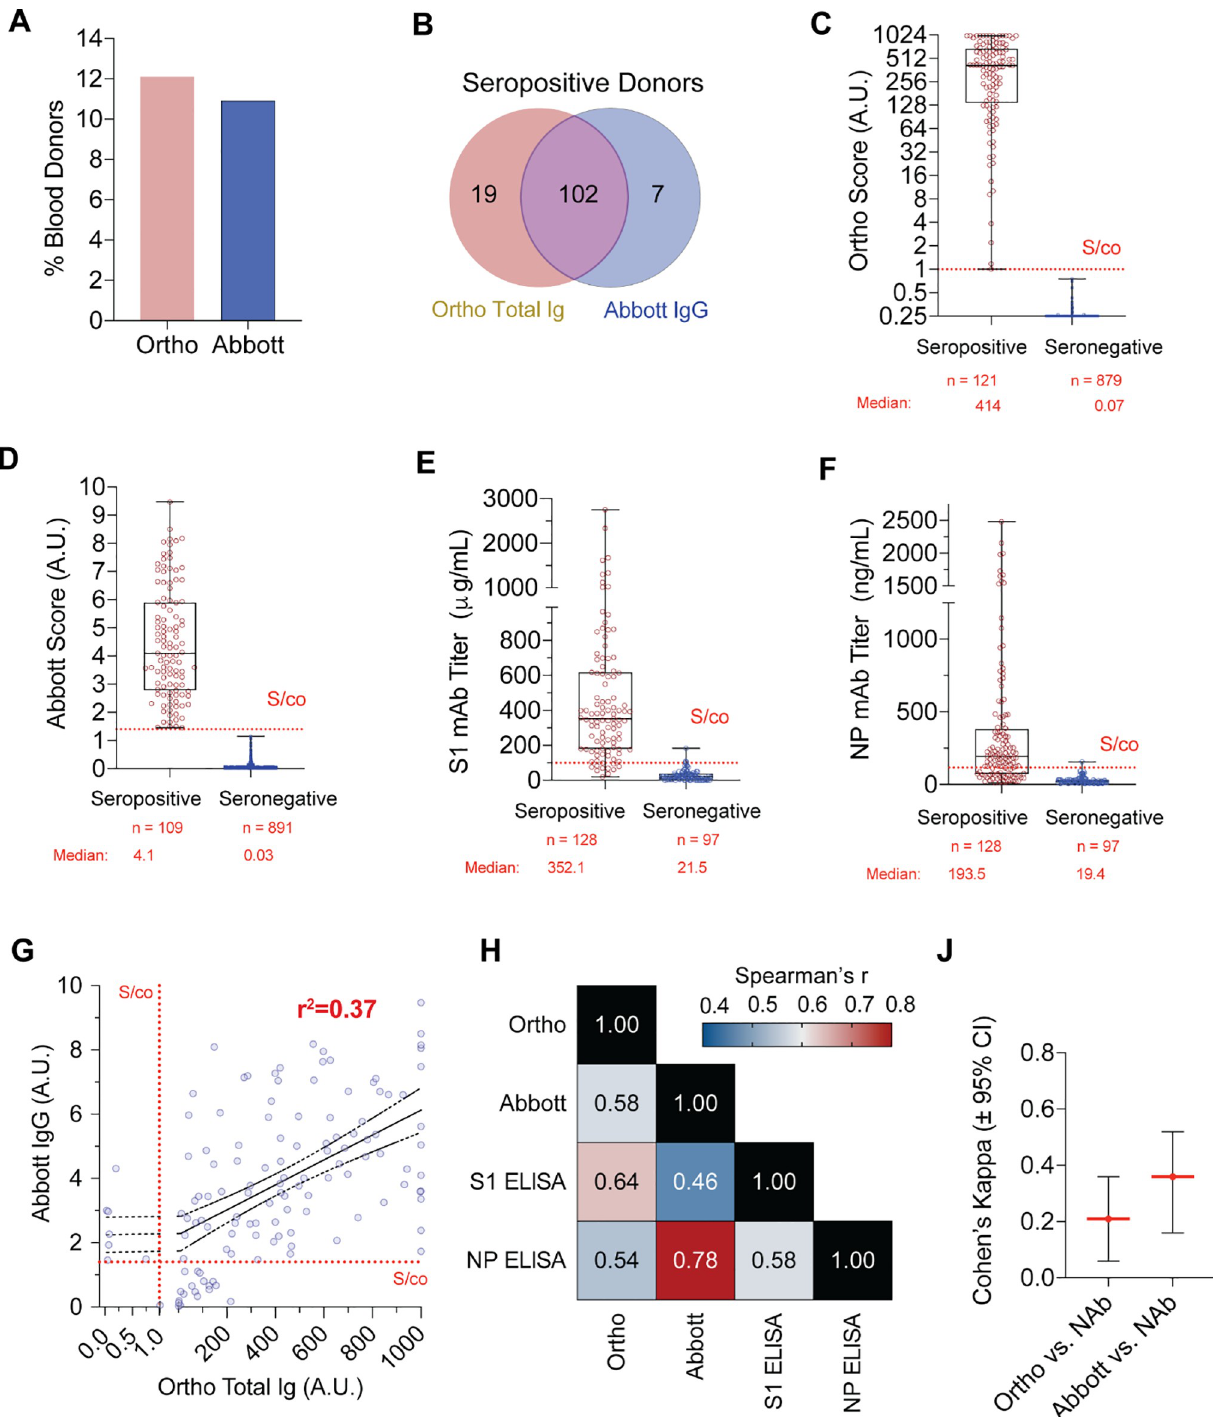
Fig 2. Serological and neutralizing activity analysis of NYC metro blood donors. A; Frequency of NYC Metro area seropositive donors as determined using the Ortho Total Ig (yellow bar) or Abbott IgG (blue bar) HTSA assays. B; Venn diagram of donors determined to be seropositive using the Ortho (yellow) or Abbott (blue) HTSA assays. Seropositive donors that were reactive for both tests are indicated in overlap (green). C; Distribution of Ortho HTSA serological results between seropositive (red dots) and seronegative (blue dots) as determined by the Ortho HTSA assay. Median value and sample number is shown below graph. Dotted line shows S/co value (1.00 A.U.). D; Distribution of Abbott HTSA serological results between seropositive (red dots) and seronegative (blue dots) as determined by the Abbott HTSA assay. Median value and sample number is shown below graph. Dotted line shows